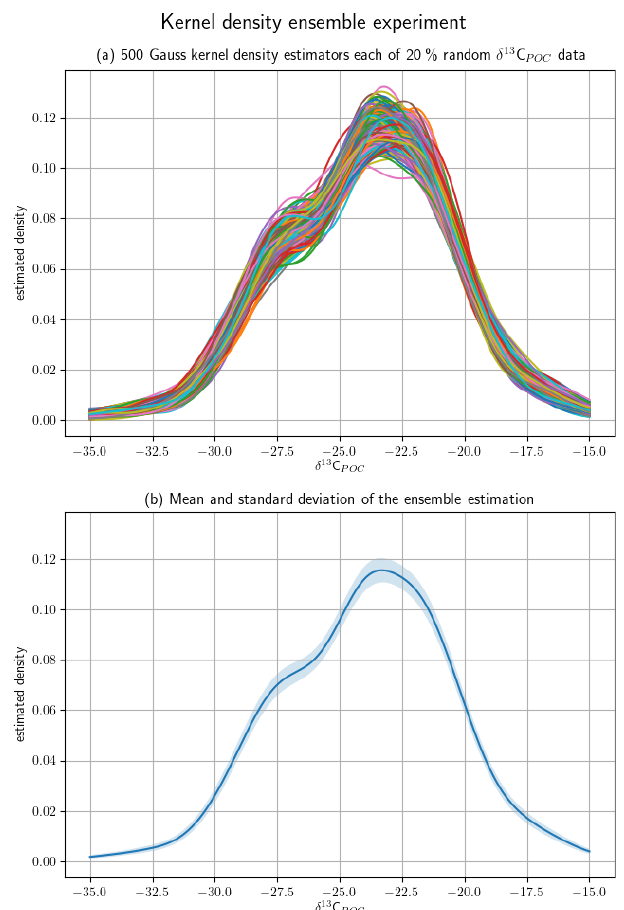
Figure 2. A random sample of 20% of the δ 13 C POC data was taken from the full data set for 500 times to generate an ensemble of sub- sets. Their densities were approximated with a Gaussian kernel den- sity estimator. Panel (a) shows all 500 estimated densities by indi- vidual lines. Panel (b) shows the mean and the variance of the full ensemble of densities by a graph and the shaded area around it, re-